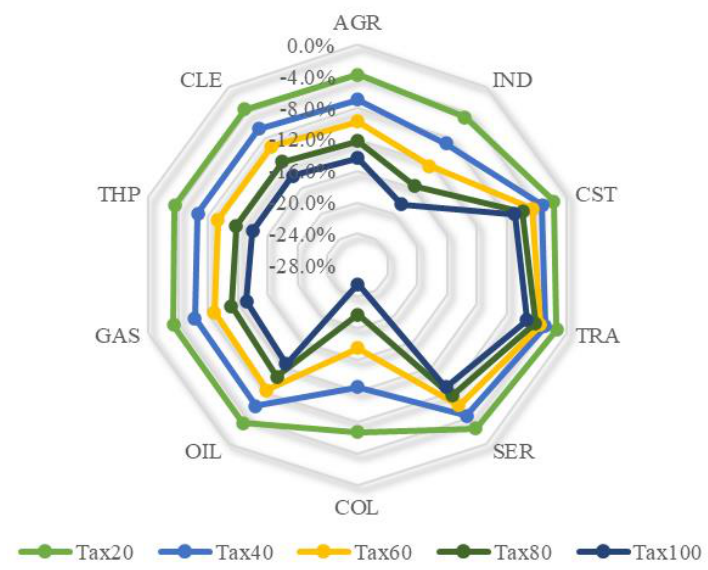
Figure 7. The variation of carbon emissions of all sectors.